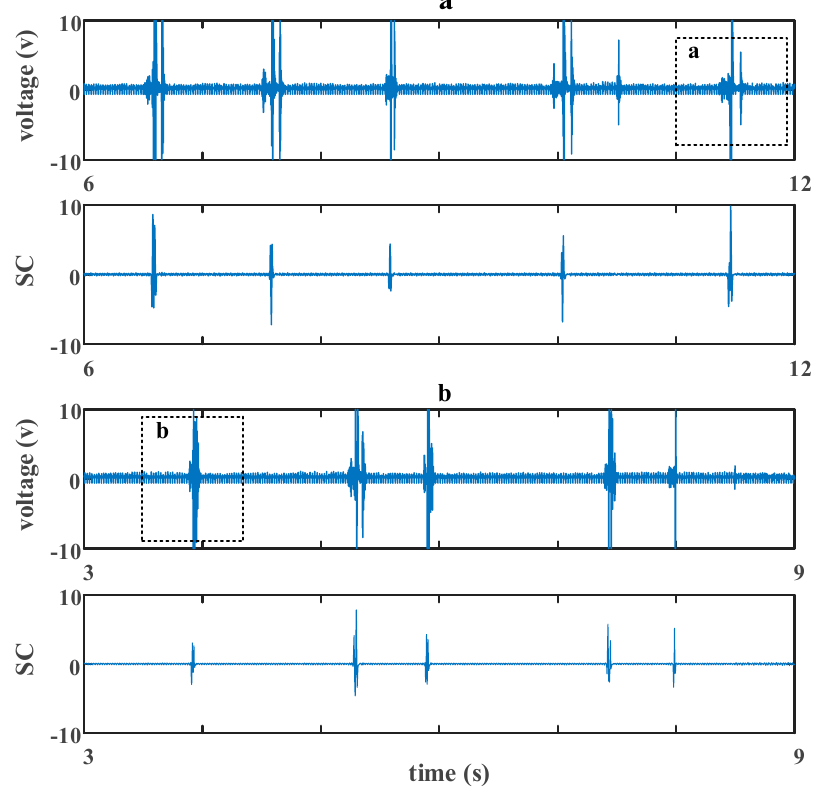
Figure 14. Performance of an experimental term when the space was 3 cm ( a ) and 6 cm ( b ).